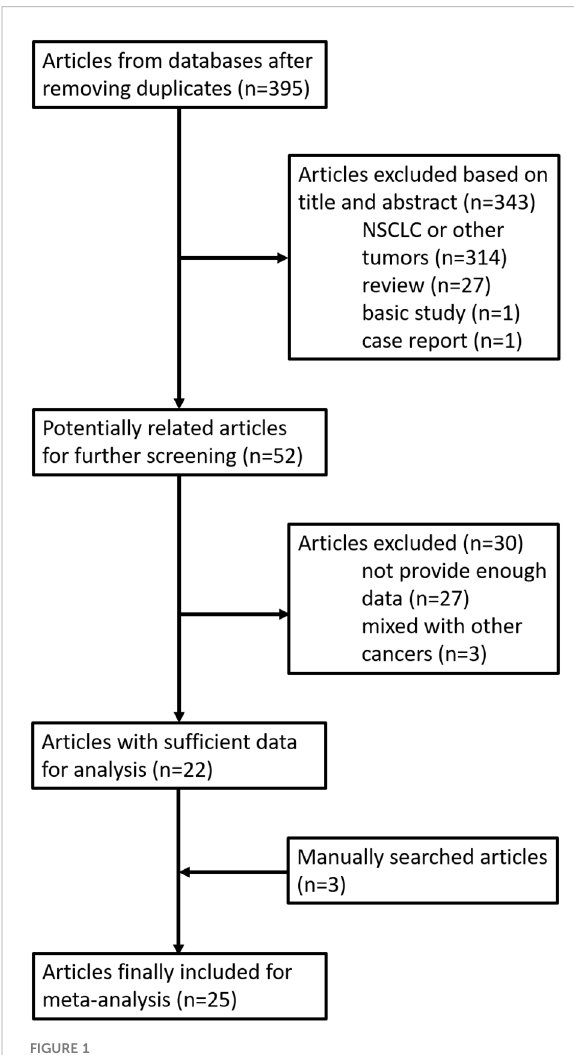
FIGURE 1 The fl owchart of the study selection process for the meta-